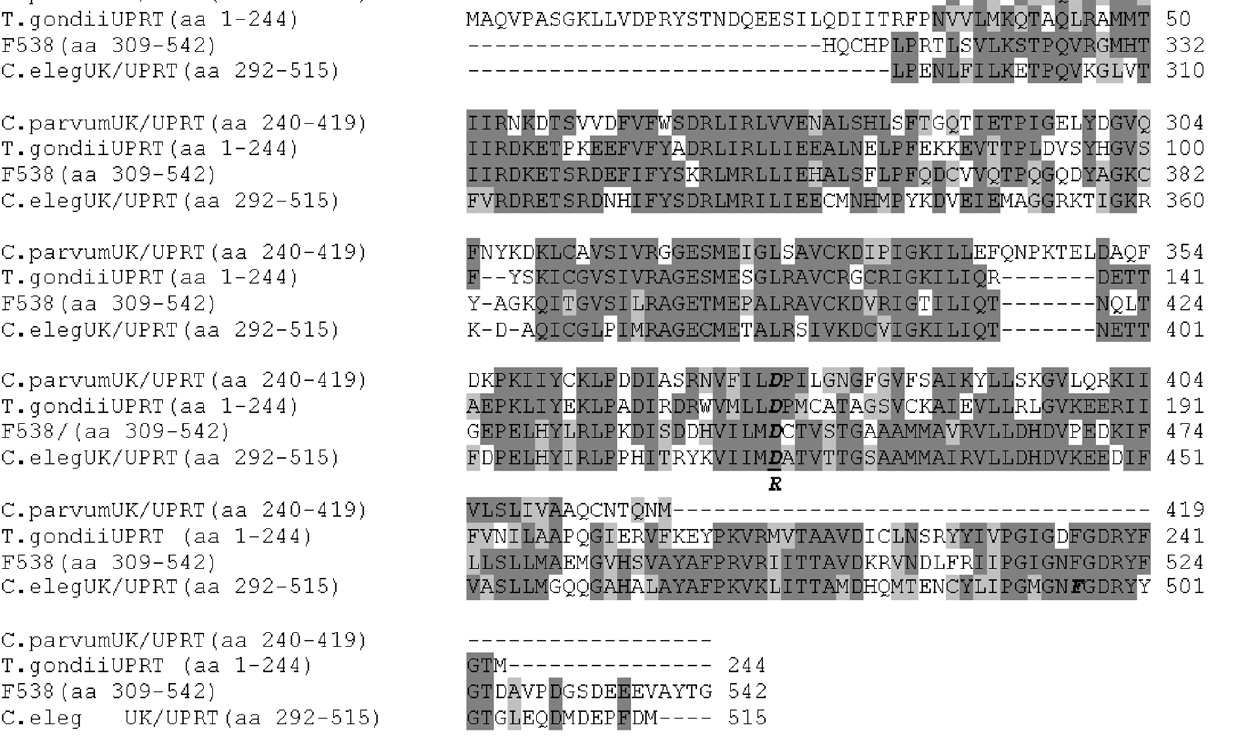
Figure 12 Multiple alignments of the C terminus of F538, T. gondii phosphoribosyltransferase (Q26998), UK/UPRT of Cryptosporidium par- vum (AAG53652) and UK/UPRT of C. elegans